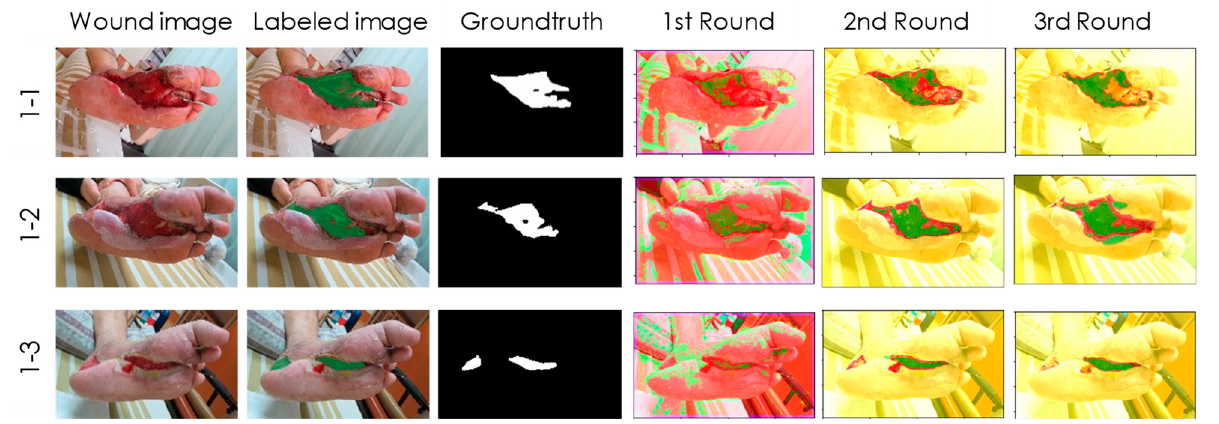
Figure 3. Case 1, a 65-year-old male patient. Although the IOU rate was around 0.6, the detection results precisely indicate the location and area of granulation tissues after the second and third training sessions.